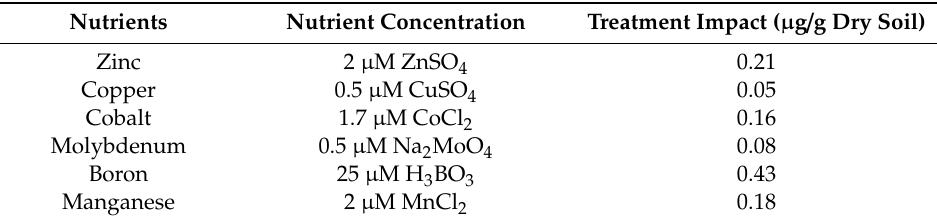
Table 4. Micronutrient experiment nutrient solutions and treatment